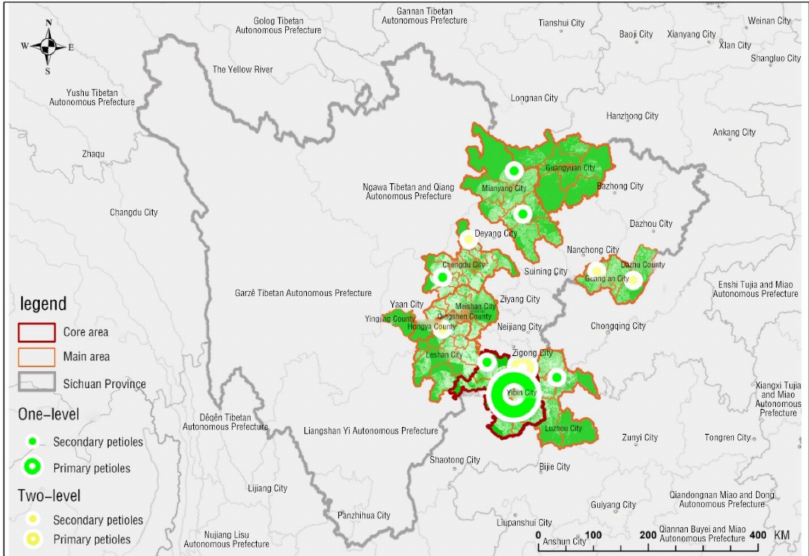
Figure 24. Distribution of petioles of research areas in Sichuan